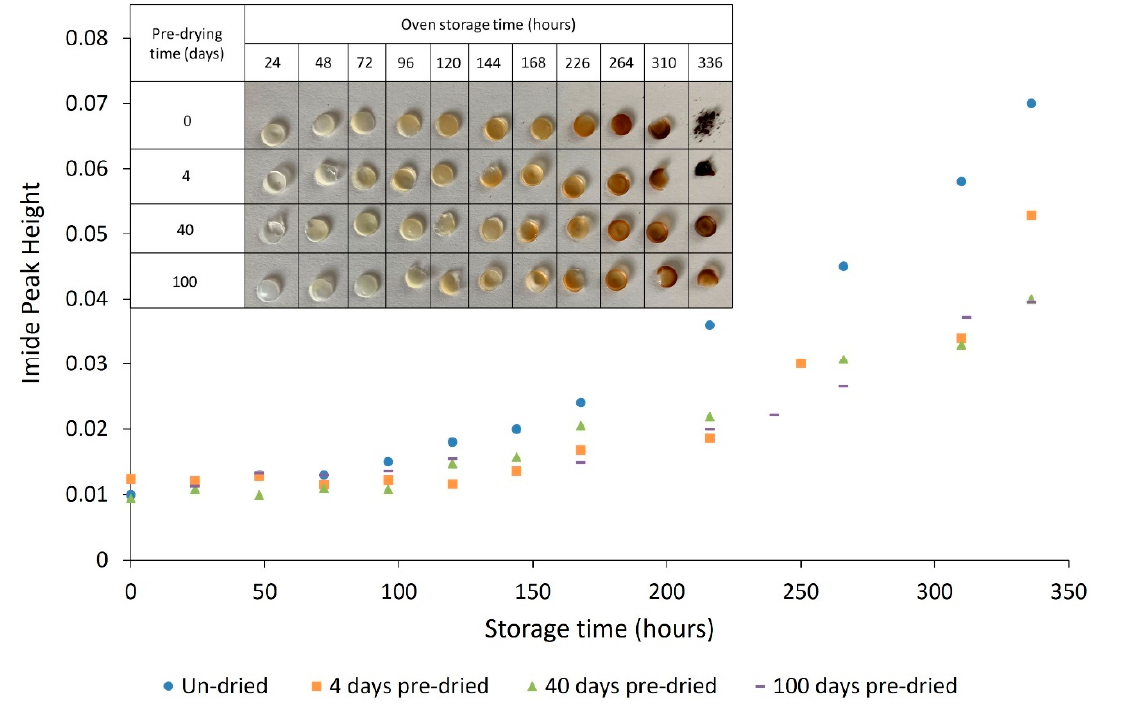
Figure 14. The effect of drying PA − 12 powders before oven conditioning on the growth of the imide peak and sample